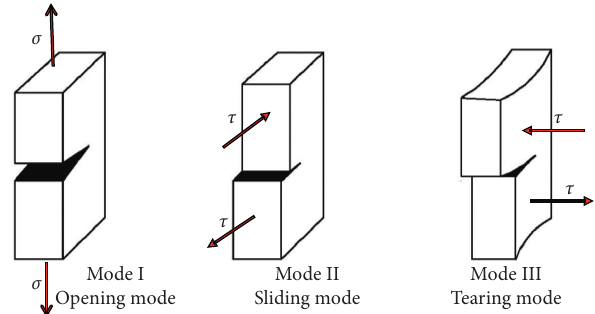
Figure 1: Basic crack model